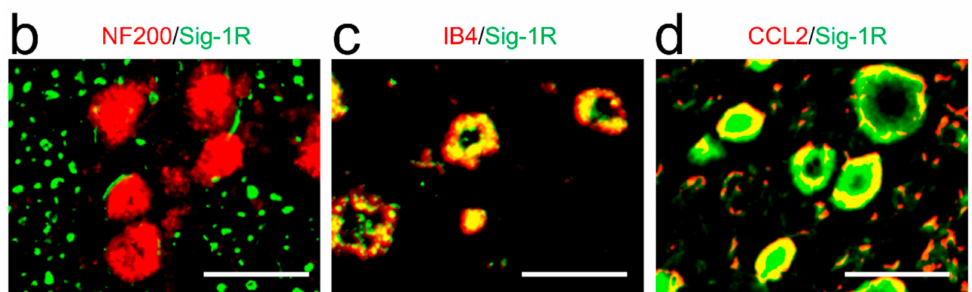
Figure 5. The distribution of sigma-1 receptor (Sig-1R) in DRG neurons after CFA-induced inflam- mation. ( a ) In DRG, Sig-1R immunoreactivity on the 7th day after CFA-induced inflammation was significantly higher than in the non-inflamed control rats (3 rats in each group; scale bar = 100 µ m, *** p < 0.001; Tukey’s multiple comparison test). Double-labeling study showing Sig-1R immunoreac- tivity extensively overlapped with IB4 ( c ) and CCL2 ( d ), but not with NF200 ( b ). Scale bar = 10 µ